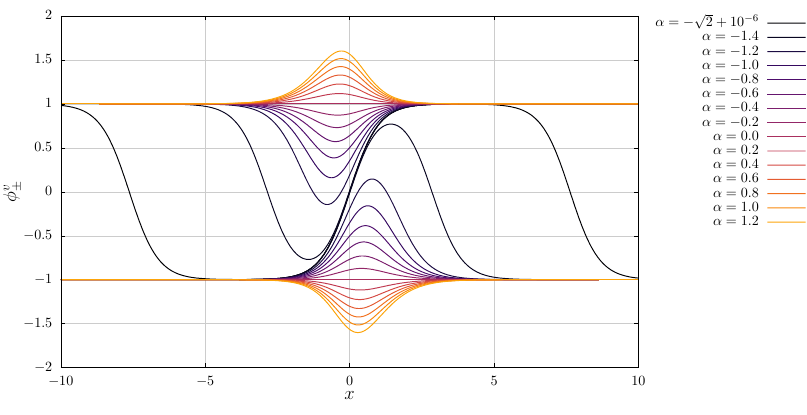
Figure 7 . Topologically trivial lumps (cid:6) + and (cid:6) (cid:0) for di(cid:11)erent values of (cid:11)